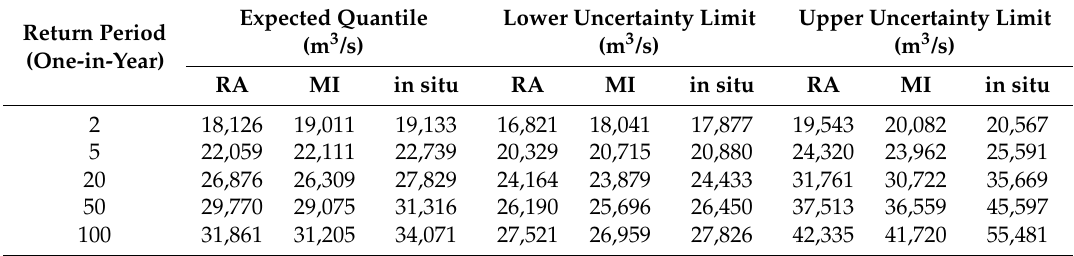
Table 6. Lokoja flood quantile estimates and uncertainty boundaries for in situ, MI, and RA filled